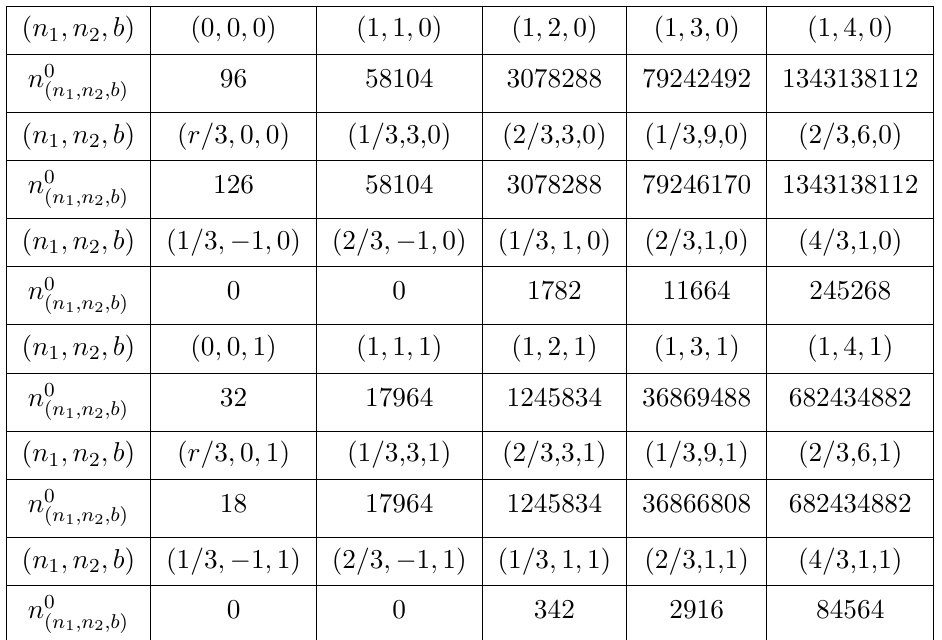
Table 17 . 3 A orbifold, non-standard embedding with single Wilson line. Shift is given by, (cid:13)